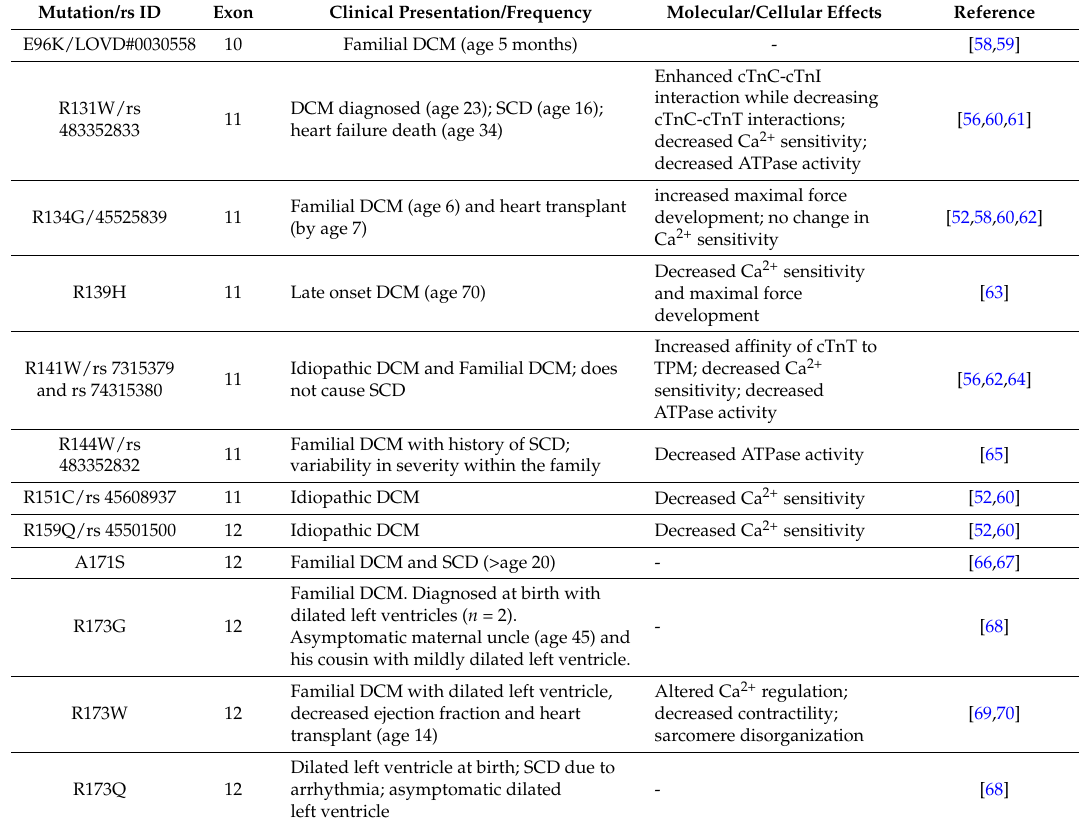
Table 1. Mutations found in TNNT2 associated with dilated cardiomyopathy, sudden cardiac death (SCD), dilated cardiomyopathy (DCM), hypertrophic cardiomyopathy (HCM), Leiden Muscular Dystrophy